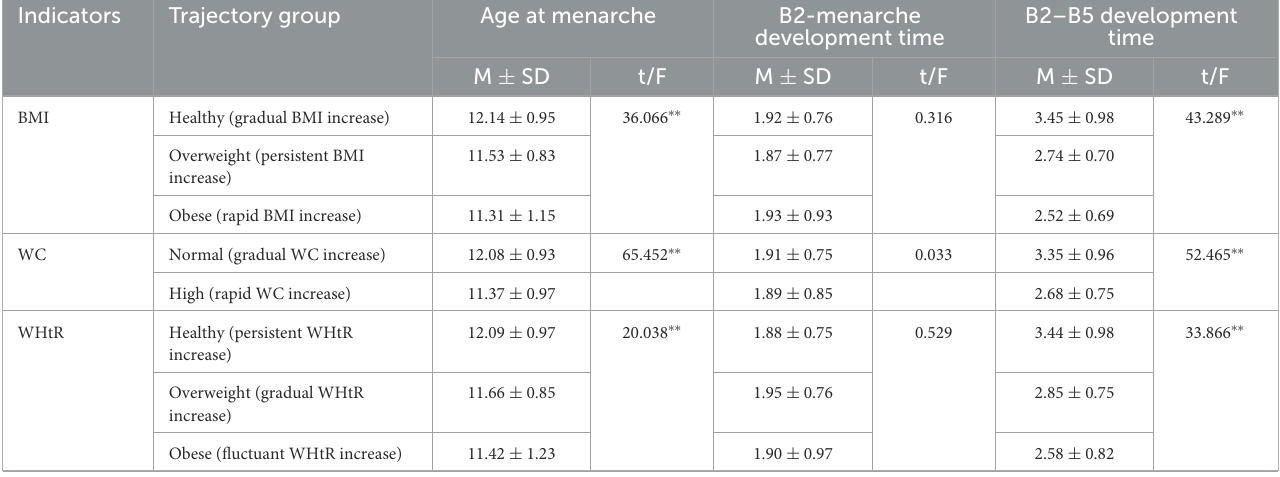
TABLE 5 Comparison of pubertal development indicators under the trajectories of obesity indicators before menarche. Indicators